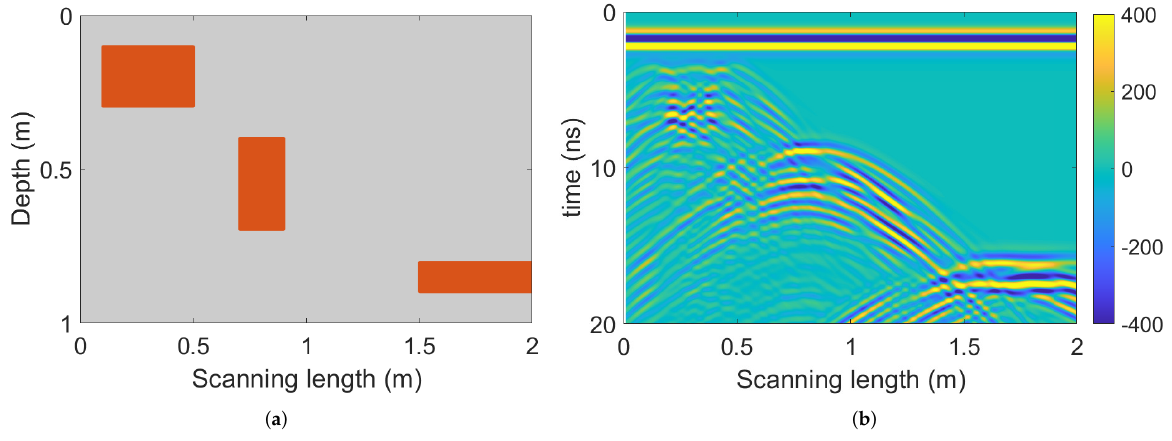
Figure 10. ( a ) Simulated subterranean area with three fractured rock portions (0.1 ≤ x ≤ 0.5 m and 0.1 ≤ z ≤ 0.3 m; 0.7 ≤ x ≤ 0.9 m and 0.4 ≤ z ≤ 0.7 m; 1.5 ≤ x ≤ 2 m and 0.8 ≤ z ≤ 0.9 m). ( b ) The pre-processed radargram.